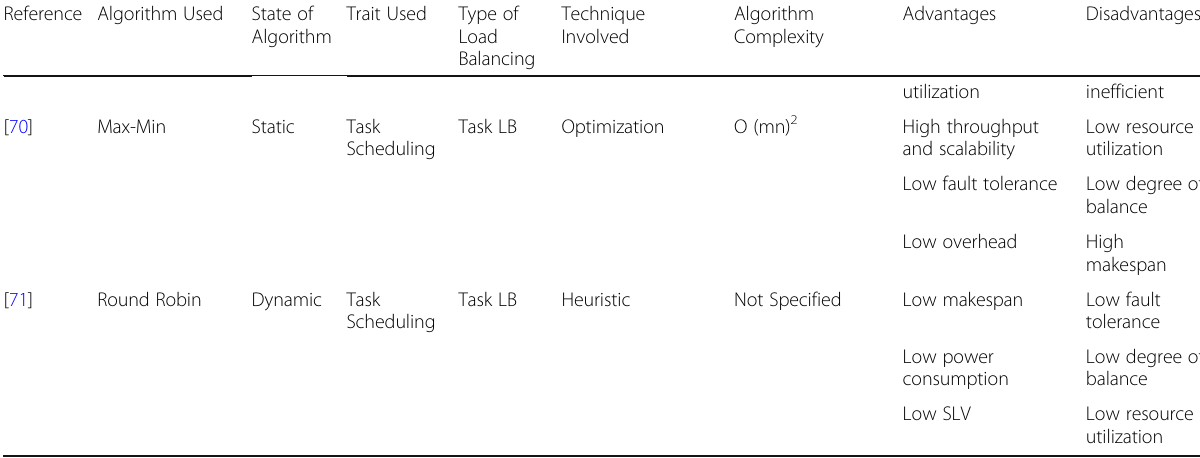
Table 2 Reactive approaches of cloud load balancing in existing literature (Continued) Reference Algorithm Used